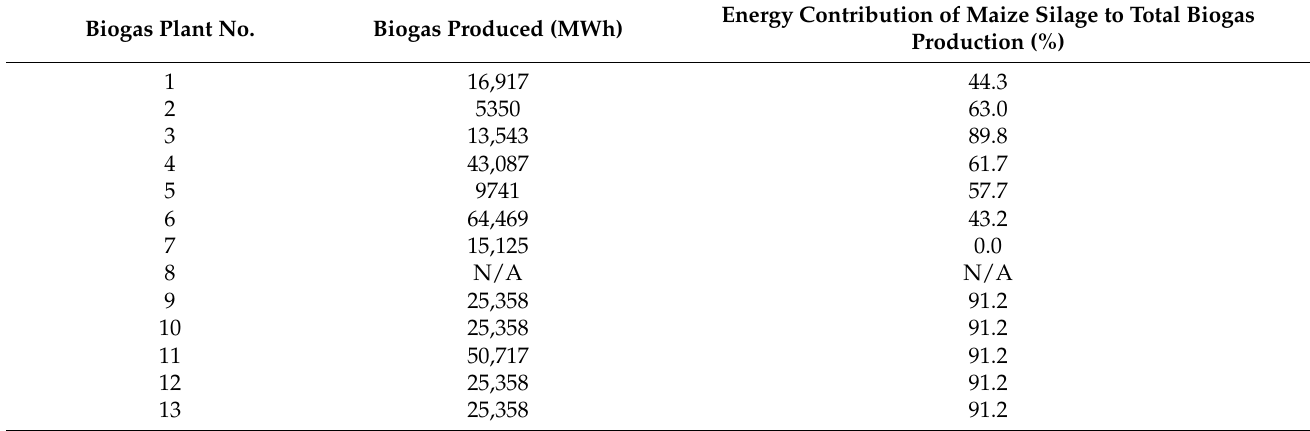
Table 2. Energy produced in the biogas